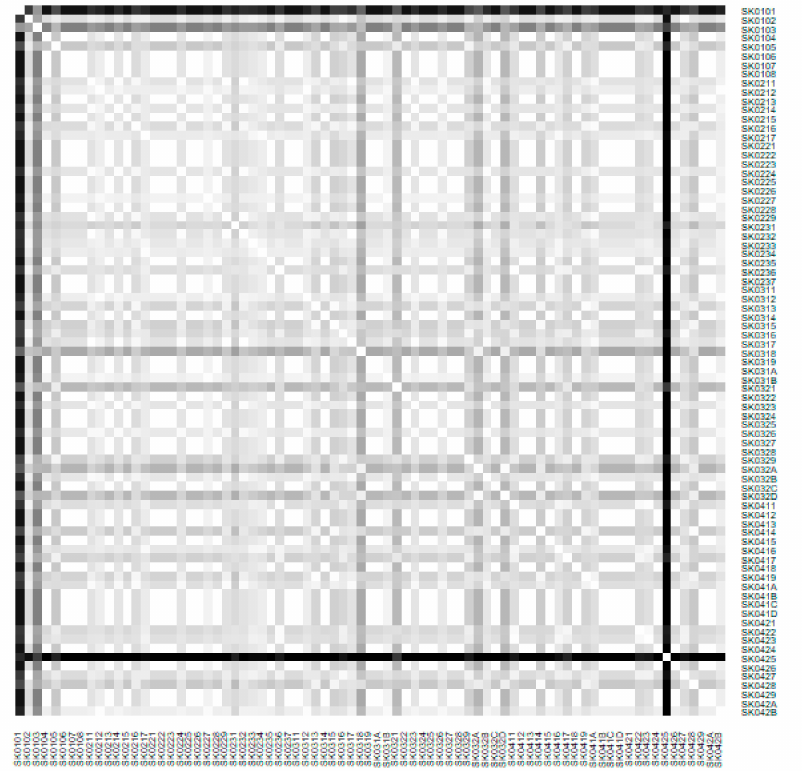
Figure 2. Medical equipment heat map of the districts in the year 2008. Source: own elaboration by the authors.